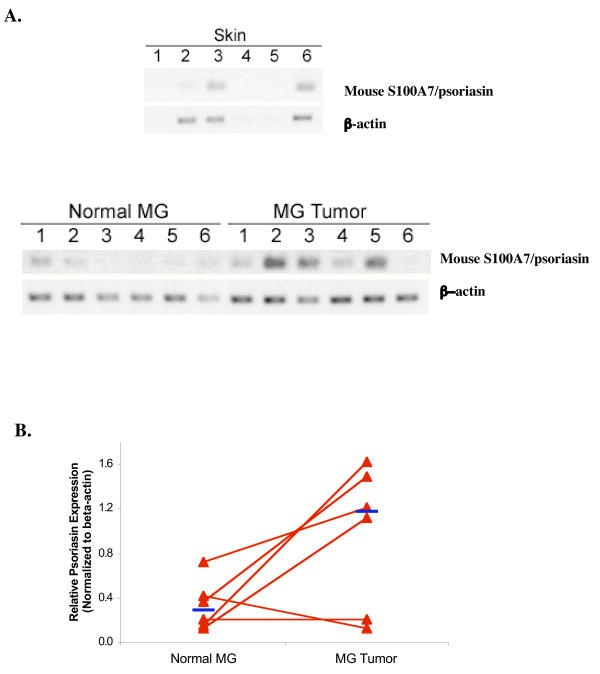
A Top panel Expression of mouse S100A7/psoriasin in normal skin RNA from normal mouse skin from 6 different animals (1–6) was subjected to RT-PCR analysis using mouse psoriasin-ORF primers and β-actin primers as described in Materials and Methods. PCR products of 344 bp for mouse S100A7/psoriasin and 330 bp for β-actin are shown. Bottom panel Expression of mouse S100A7/psoriasin in normal mouse mammary gland) and DMB A induced mammary tumors RNA from freshly frozen matched normal mammary gland (Normal MG) and DMBA induced mammary tumors (MG tumor) from 6 different CD1 mice (1–6) was extracted and subjected to RT-PCR analysis using mouse psoriasin-ORF primers and β-actin primers as described in Materials and Methods. PCR products of 344 bp for mouse S100A7/psoriasin and 330 bp for β-actin are shown. B Semi-quantitative analysis of the results shown in bottom panel of A Data points represent the means of three independent PCR reactions. The value of mouse S100A7 normalized to β-actin for each matched normal MG and MG tumor sample are joined by red lines. Blue lines represent the median value of mouse S100A7/psoriasin expression for each tissue type. Increased expression in MG tumors is significant (p < 0.05, one sided Wilcoxon signed rank test).